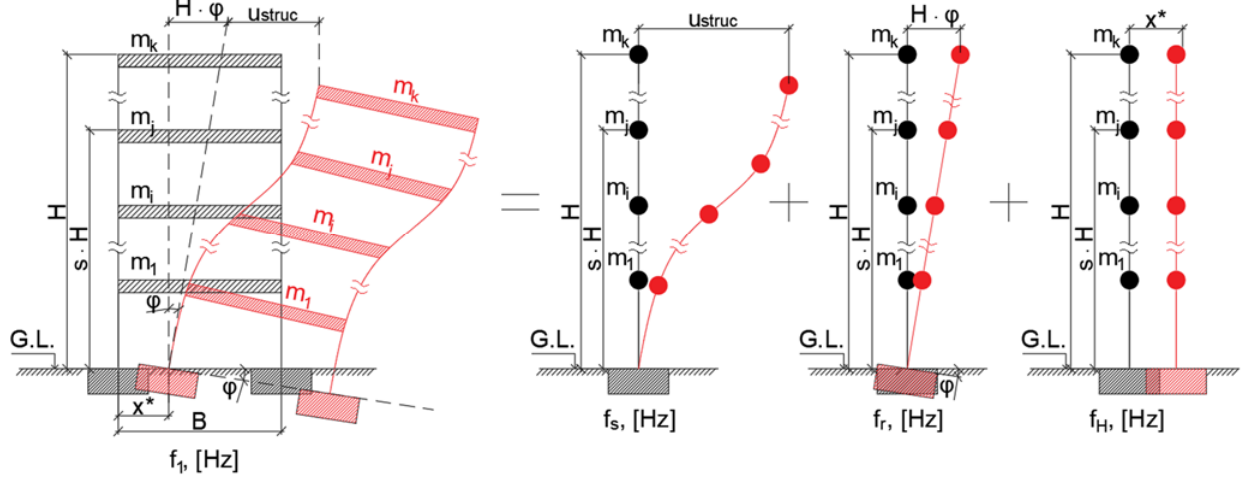
Figure 1. Multi ‐ mass model scheme of building frame; f 1 —fundamental frequency, f s —frequency of shear frame action, f r —frequency of rocking action, f h —frequency of horizontal movement (not considered in this paper further), u struc —shear deformation of frame, H—building height, x*—horizontal displacement.